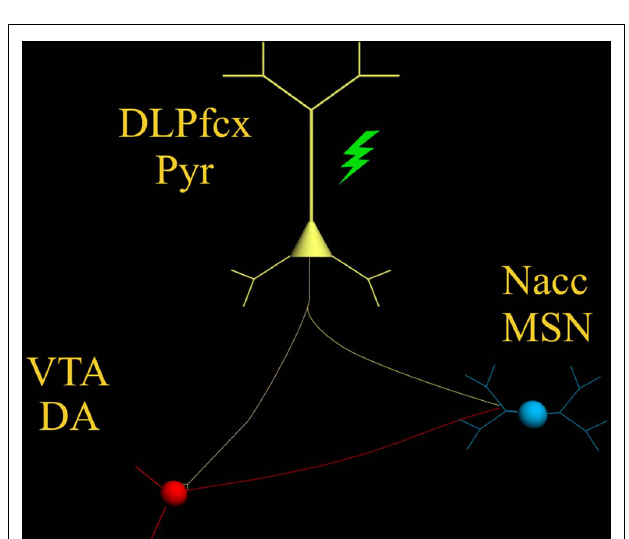
FIGURE 2 |The scheme illustrates the proposed circuit to be activated by theTMS stimulus (green) which, by activating the pyramidal neuron (yellow) with its neurotransmitter glutamate, would excite: (1) DA-containing neurons of theVTA (red) and (2) MSN of the Nacc